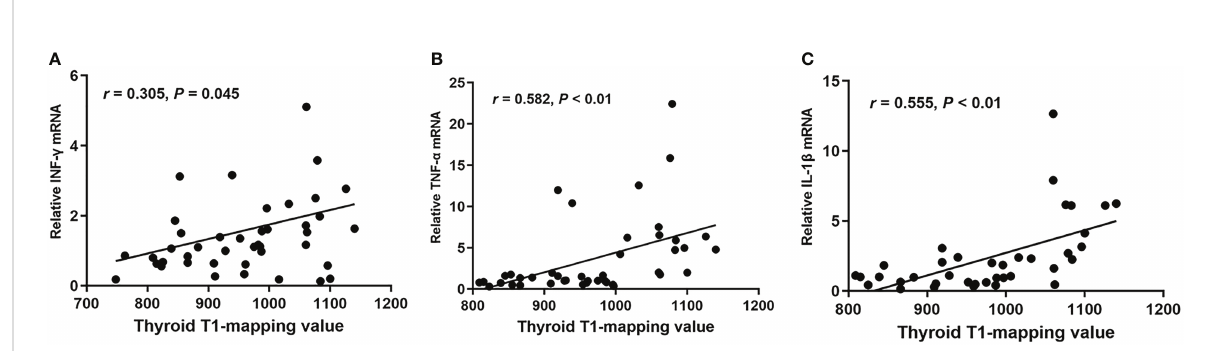
FIGURE 2 The correlation between thyroid T1-mapping values and the mRNA expression of INF- g (A) , TNF- a (B) , and IL-1 b (C) in thyroid tissues. Thyroid T1-mapping values were signi fi cantly associated with the mRNA expression of INF- g , TNF- a , and IL-1 b in thyroid tissues ( INF- g : r = 0.305, P = 0.045; TNF- a : r = 0.582, P < 0.01; IL-1 b : r = 0.555, P < 0.01). A bivariate correlation analysis was performed using the Spearman test. r represents the Spearman correlation coef fi